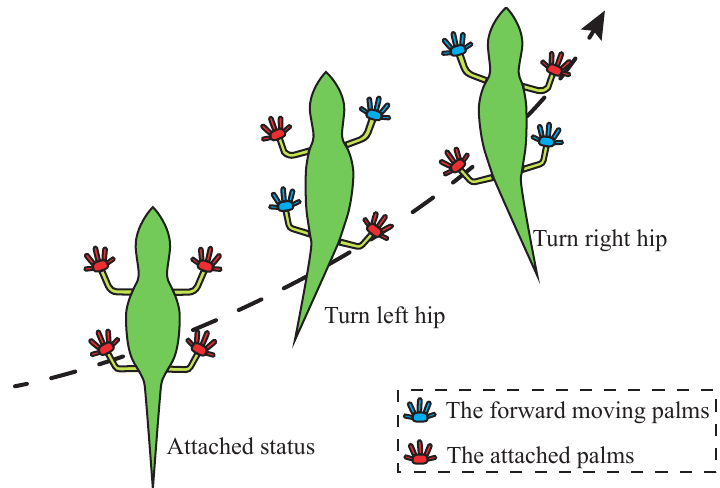
Figure 5. Forward movement strategy of an anole